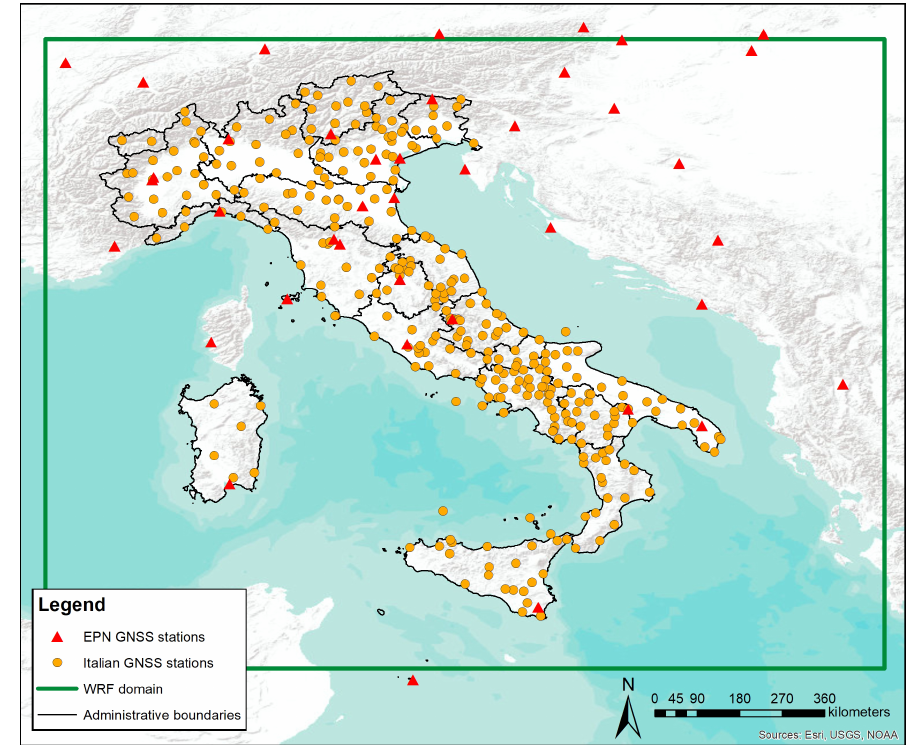
Figure 4. Italian Global Navigation Satellite System (GNSS) receivers (yellow dots) and EPN (European Permanent Network) GNSS receivers (red triangles) used in the present